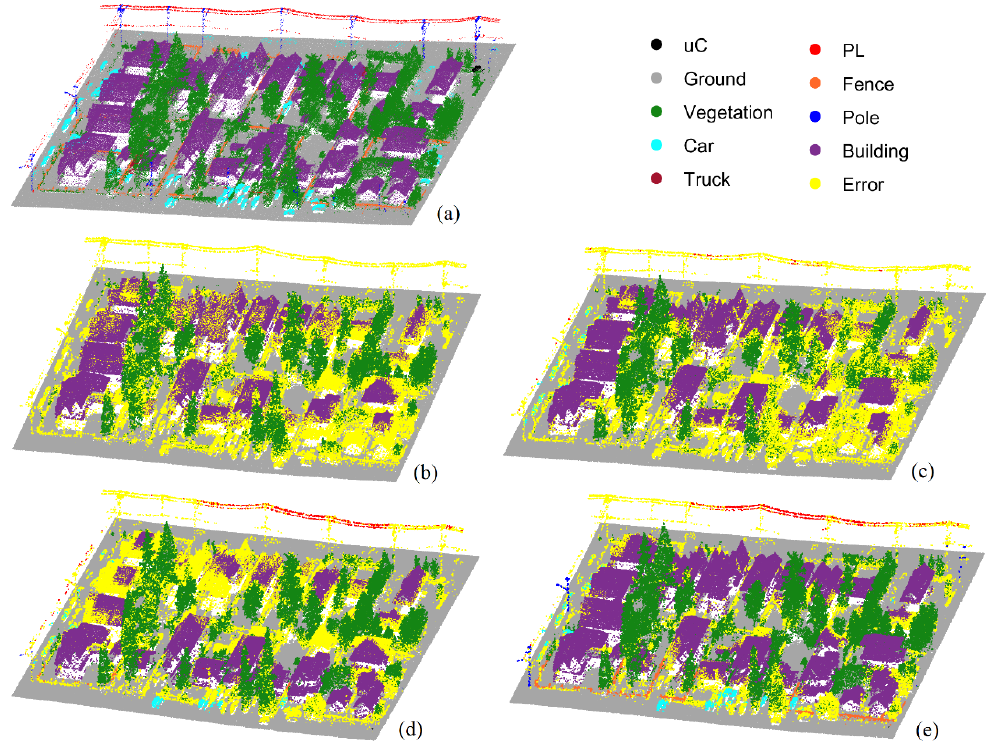
Figure 3. Classification results (misclassified points are in yellow) for the DALES Test 3 data set: (a) ground-truth, (b) train/test split, (c) bootstrap, (d) k CV, and (e) k CV-B. uC, Veg and PL define unclassified, vegetation and power line, respectively. Training Class points